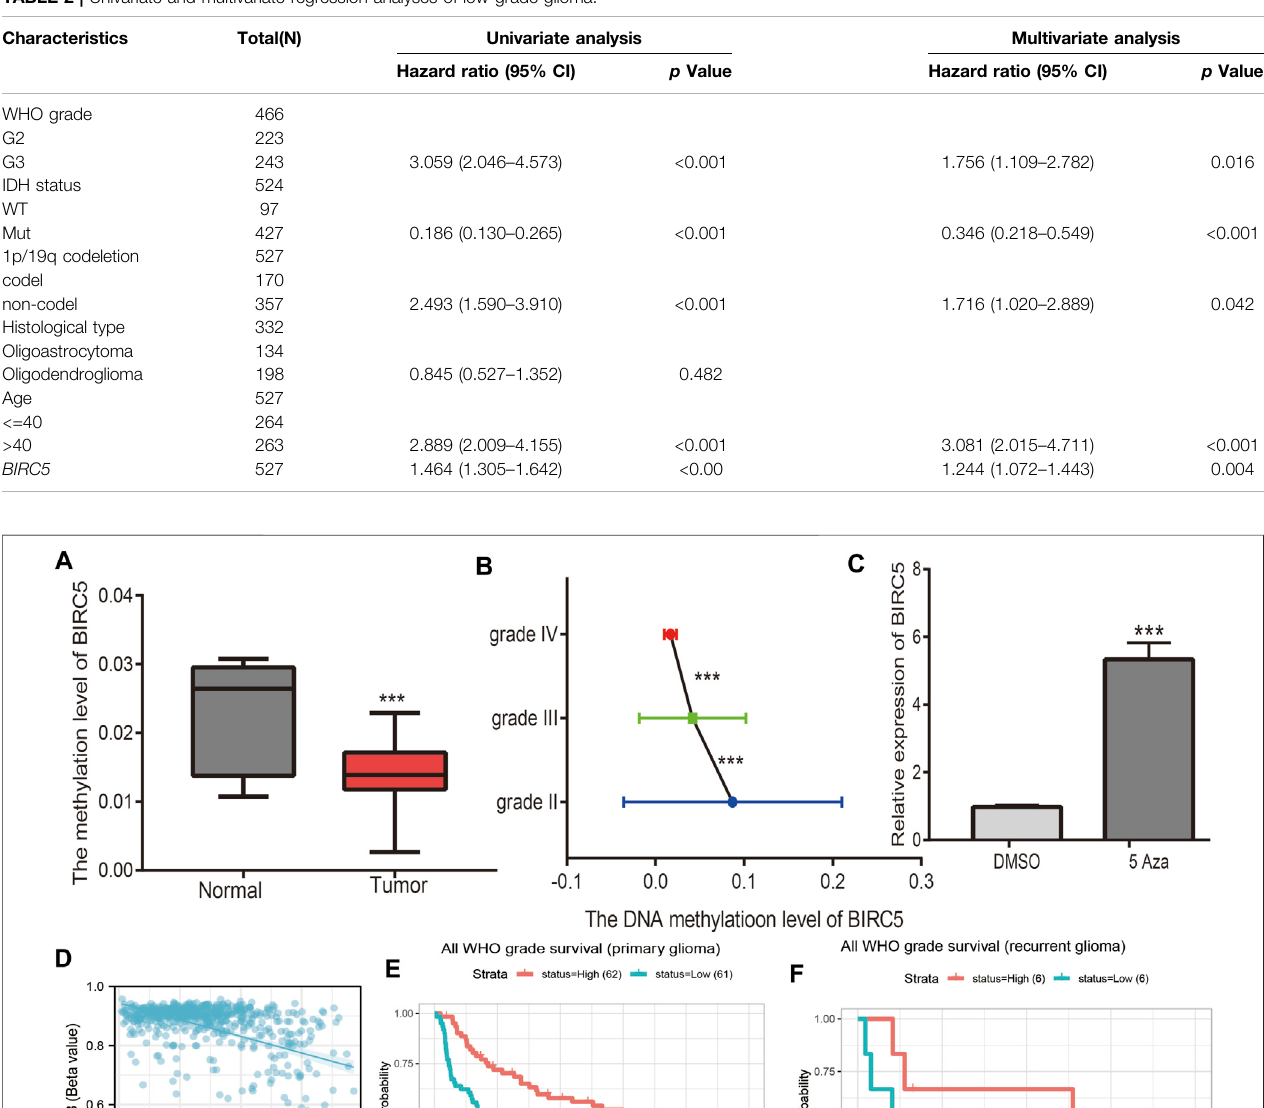
TABLE 2 | Univariate and multivariate regression analyses of low-grade glioma. Characteristics